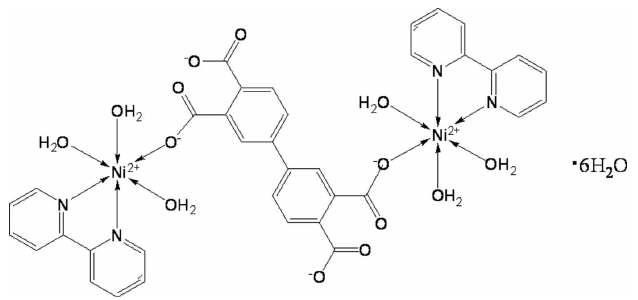
DIAMOND (Brandenburg & Putz, 2006) and ORTEP-3 for publication: SHELXTL (Sheldrick,